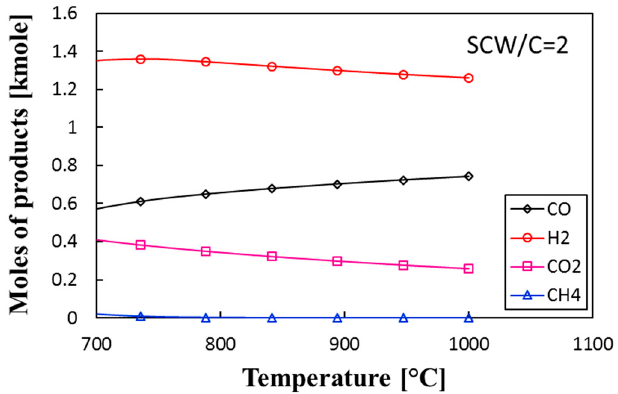
Figure 6. Variation of the mole fraction of the products with temperature at the reference condition in reactor at the supercritical water to fuel ratio (SCW / C) =